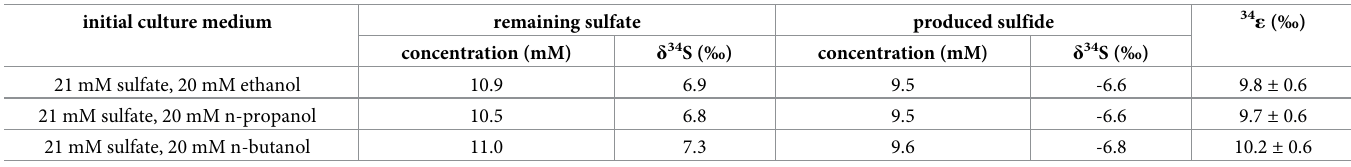
All concentrations and sulfur isotope compositions were determined at 140 hr (Fig